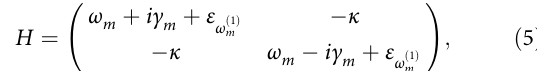
enables single-mode oscillation of the WSR-based PT-symmetric